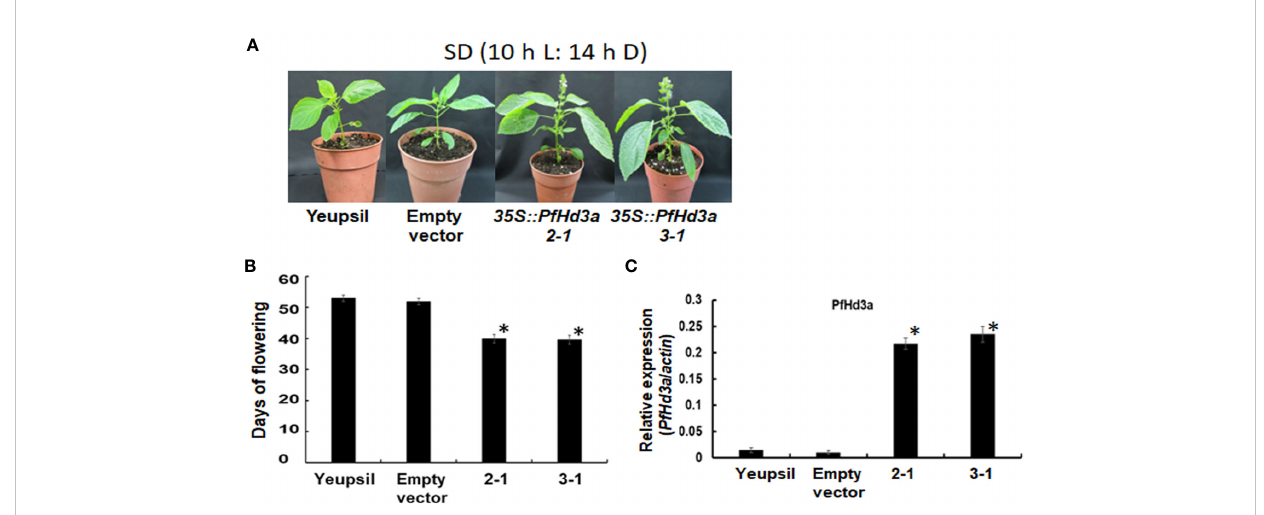
FIGURE 5 Flowering phenotype of transgenic perillas overexpressing PfHd3a . (A) Early fl owering of 35S: PfHd3a 2-1 and 3-1 lines under SD (10 h light/14 h darkness) condition. (B) Flowering times were determined as days of fl owering after sowing at the time of fl owering under SD (10 h light/14 h darkness) condition. At least 12 plants of each genotype were used. Statistical signi fi cance was determined by Student ’ s test (*P < 0.001). (C) Transcript levels of PfHd3a in transgenic perillas. QRT-PCR was performed with cDNAs with 30-day-old yeopsil, and transgenic perillas (2-1 and 3-1) in SD (10 h light/14 h darkness) condition. Statistical signi fi cance was determined by Student ’ s test (*P < 0.05).